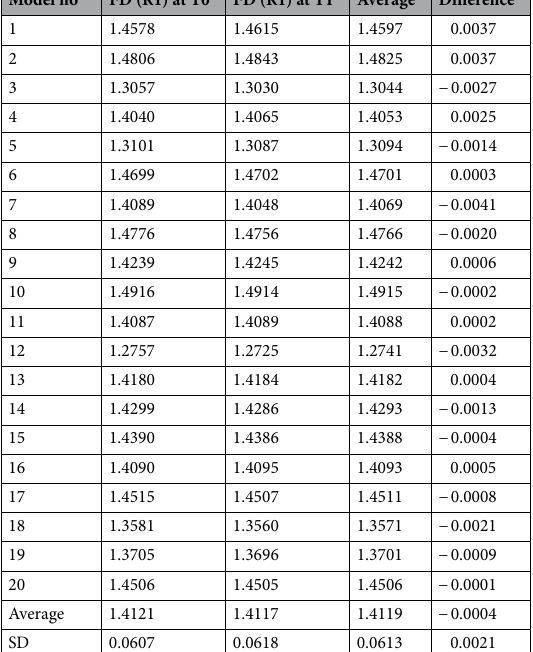
Table 2. Fractal dimensions (FD), as measured by rater 1 (R1) at baseline (T0) and at T1 = T0 + 15 days (intra- rater agreement).